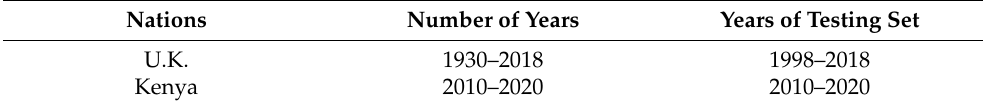
Table 2. Testing set years as per Nations.